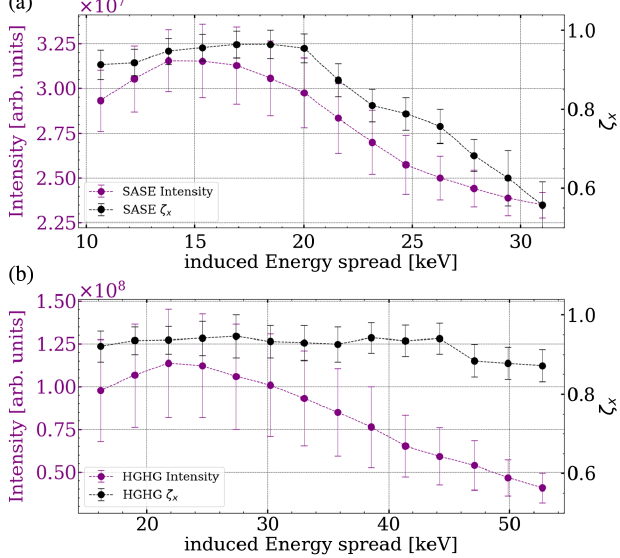
FIG. 6. Normalized total degree of coherence ζ x (black) and intensity (purple) in SASE (a) and HGHG (b) configurations, as a function of LH-induced energy spread at the laser heater position, before